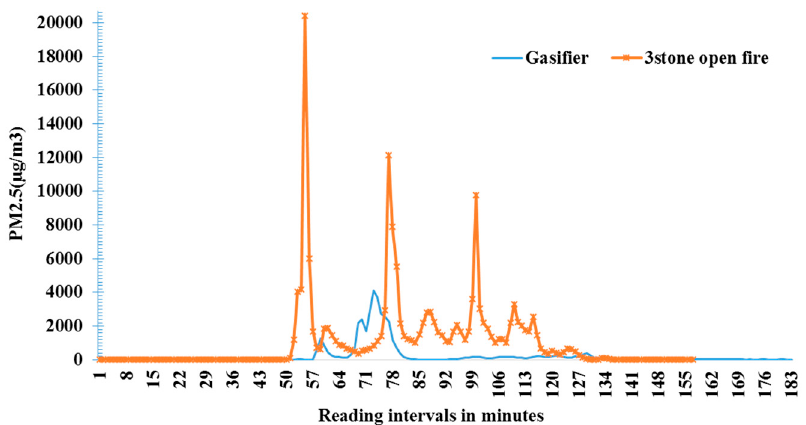
Figure 7. Concentration of CO 2 before, during and after the end of the cooking when using gasifier and three-stone open fire in the household No. 14.